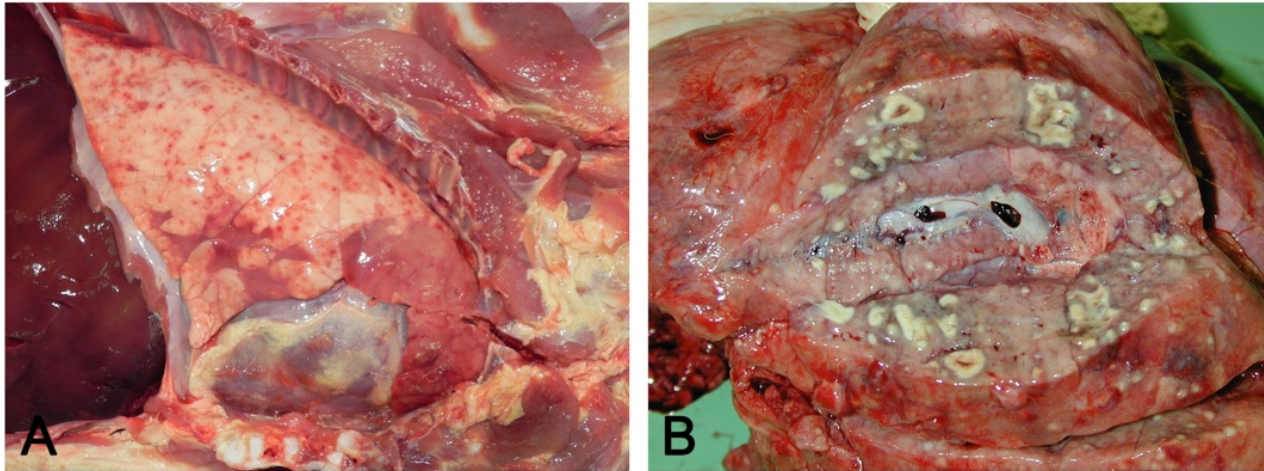
Figure 4. Hematogenous lung spread: in ( A ), together with a cranioventral pneumonia, the right basal lobe shows multiple acute and recent red foci of hyperemia/hemorrhage referable to bacteremia often of intestinal origin. In ( B ), multiple foci of suppuration surrounded by normal lung parenchyma, due to lung arrest of microthrombi originating from septic phlebitis outside the lungs.